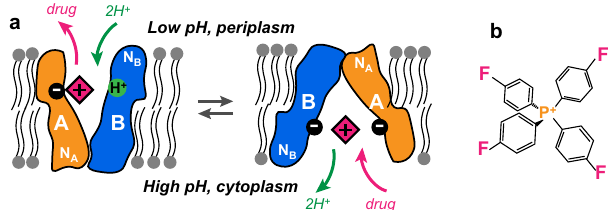
Fig. 1 Schematic of the EmrE transport function. a Simpli fi ed mechanistic model of pH-dependent substrate transport by EmrE. The binding-site structure of the cationic substrate in the dimeric protein depends on the protonation state of the proton-binding residue E14. b Structure of the substrate F 4 -TPP +